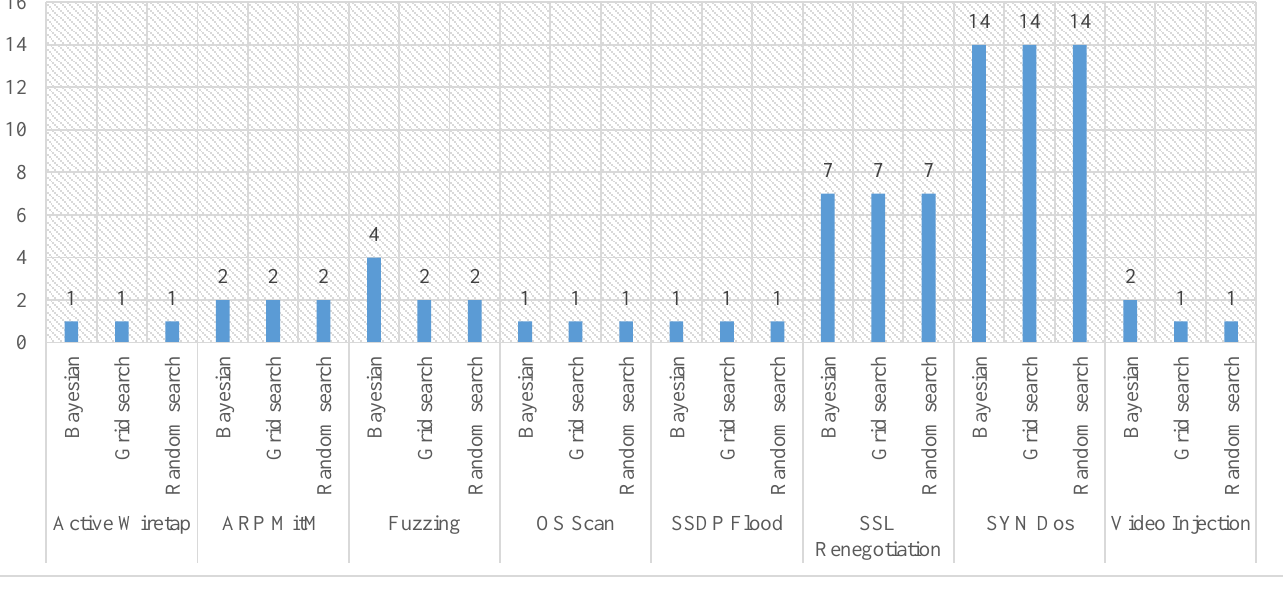
Fig. 1. Total training cost